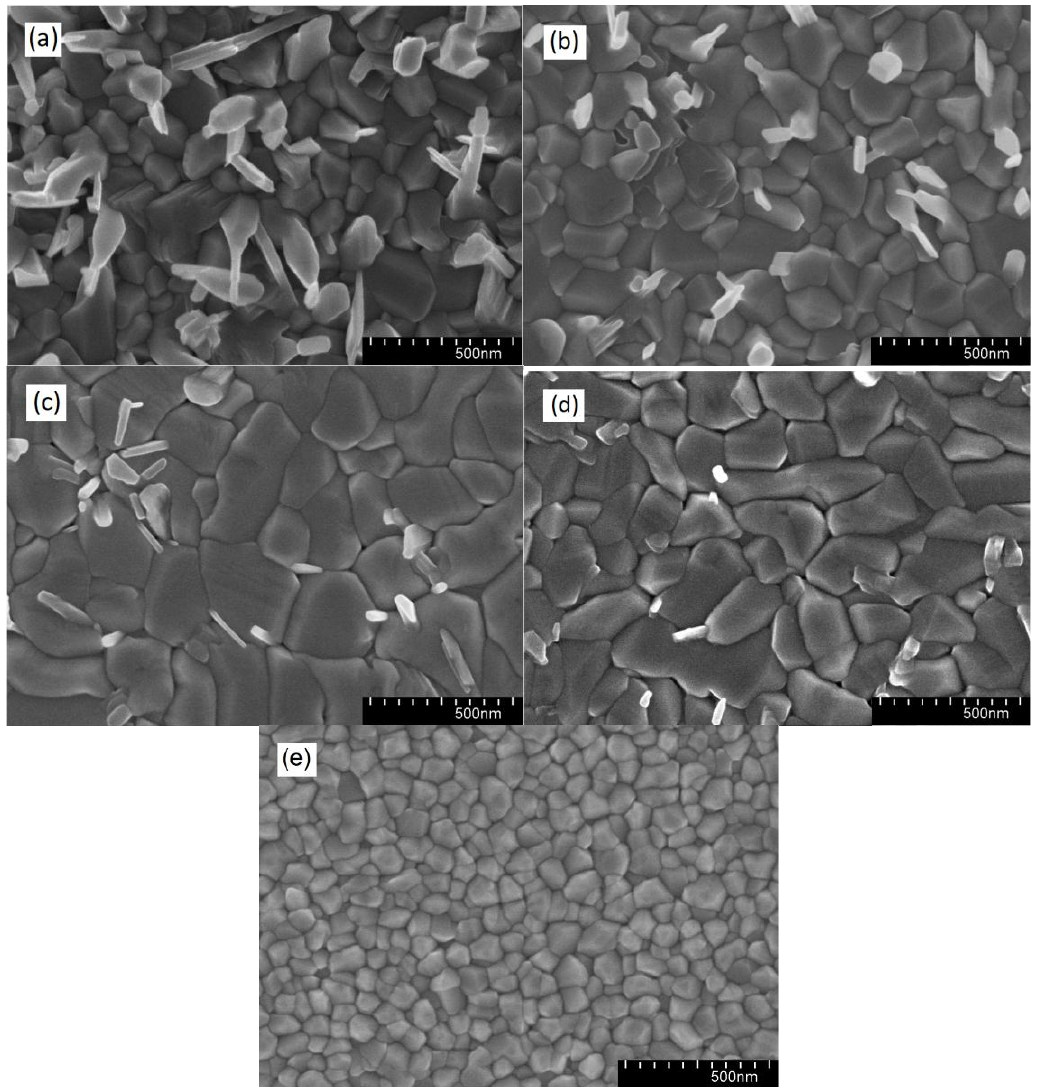
Figure 2. SEM images of VO 2 thin films deposited on Si substrates for 2 h with bias voltage of: ( a ) 89 V; ( b ) 126 V; ( c ) 146 V; ( d ) 173 V; ( e ) no bias on a sample prepared as in [23]. Table 1. Grain size and thickness of the as-deposited VO 2 thin films with substrate biasing.